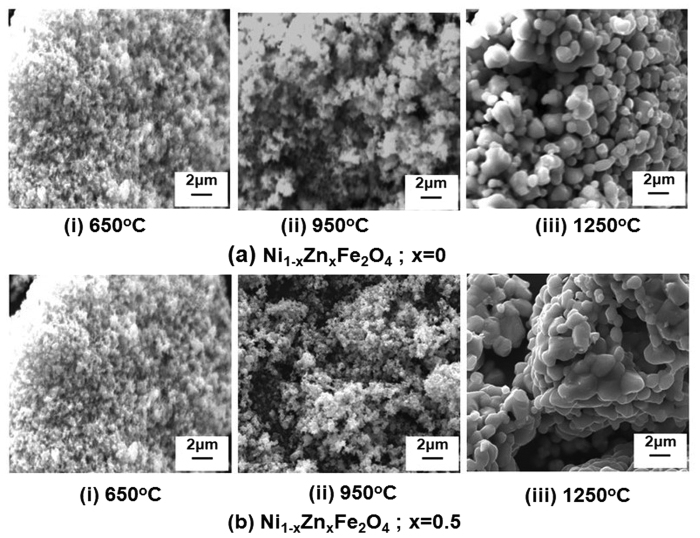
SEM micrograph of Ni1−xZnxFe2O4 powder annealed at elevated temperatures of 650 °C, 950 °C and 1250 °C for (a) x = 0 (b) x = 0.5.